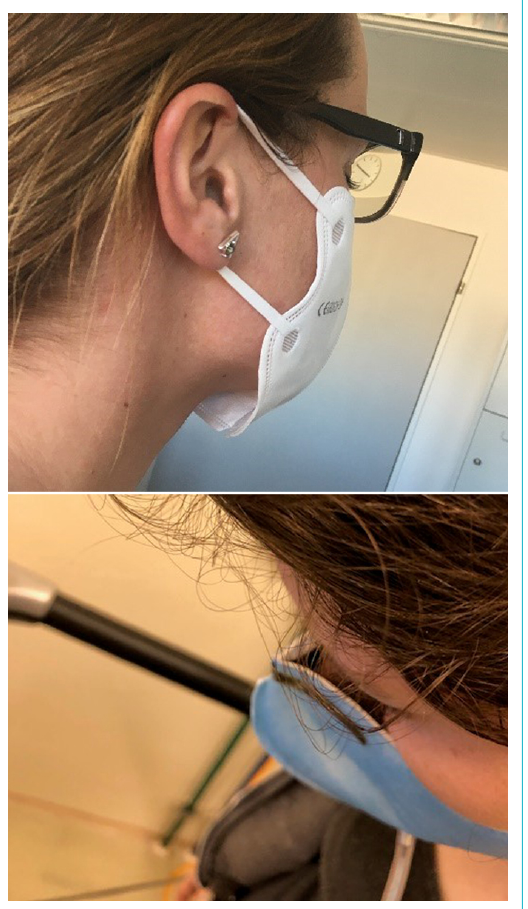
Figure 7: Example (a, above) the respirator does not properly seal onto the chin or (b, below) onto the